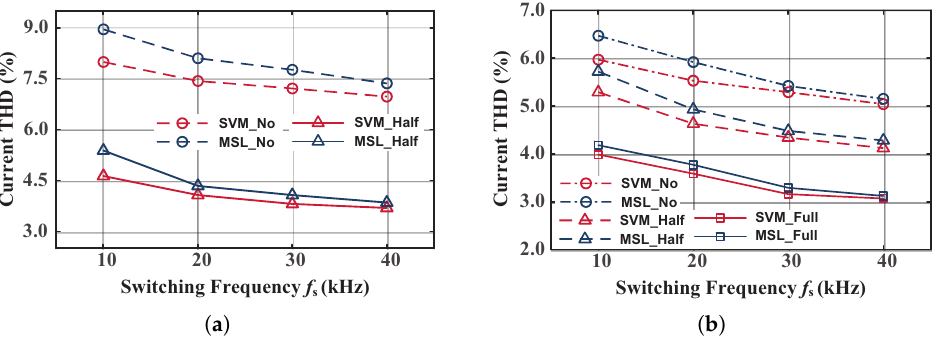
Figure 11. Comparison of current THD: ( a ) current THD at f o = 25 Hz with no and half load and ( b ) current THD at f o = 50 Hz with no, half, and full load,